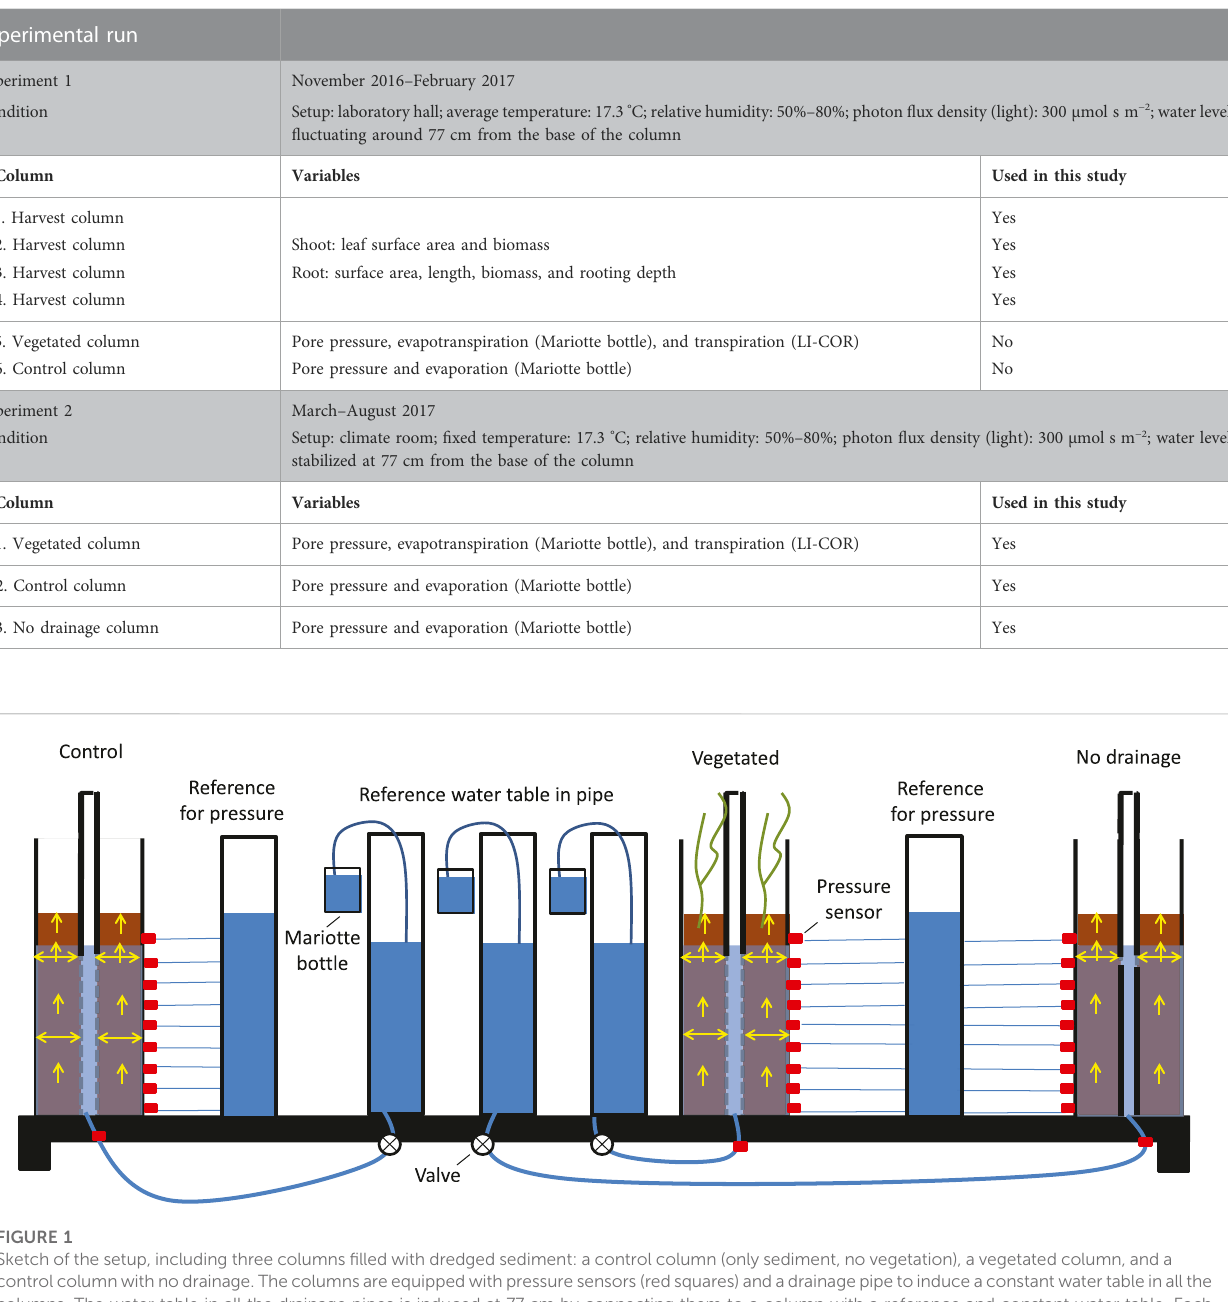
TABLE 2 Description of the two experimental runs that are part of this